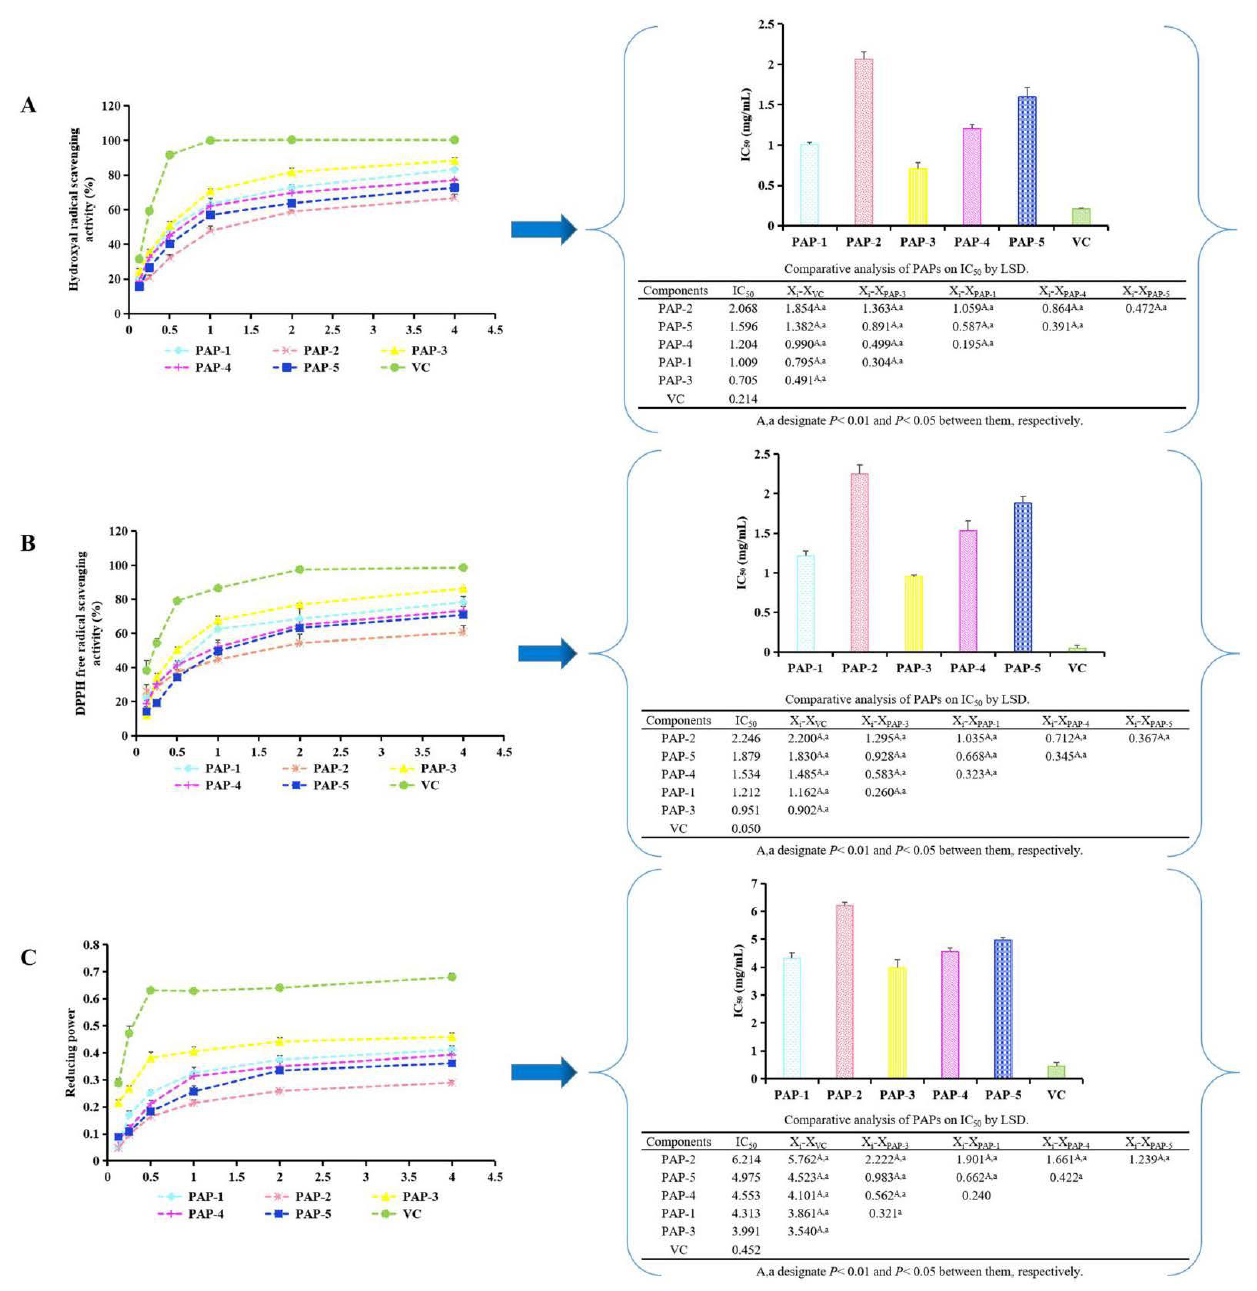
Figure 3. ( A ) Scavenging activity of PAPs on hydroxyl free radicals. ( B ) Scavenging activity of PAPs on DPPH free radicals. ( C ) Reducing power of PAPs. (means ± SD, n = 3). “A, a” designate p < 0.05 or p < 0.01 between